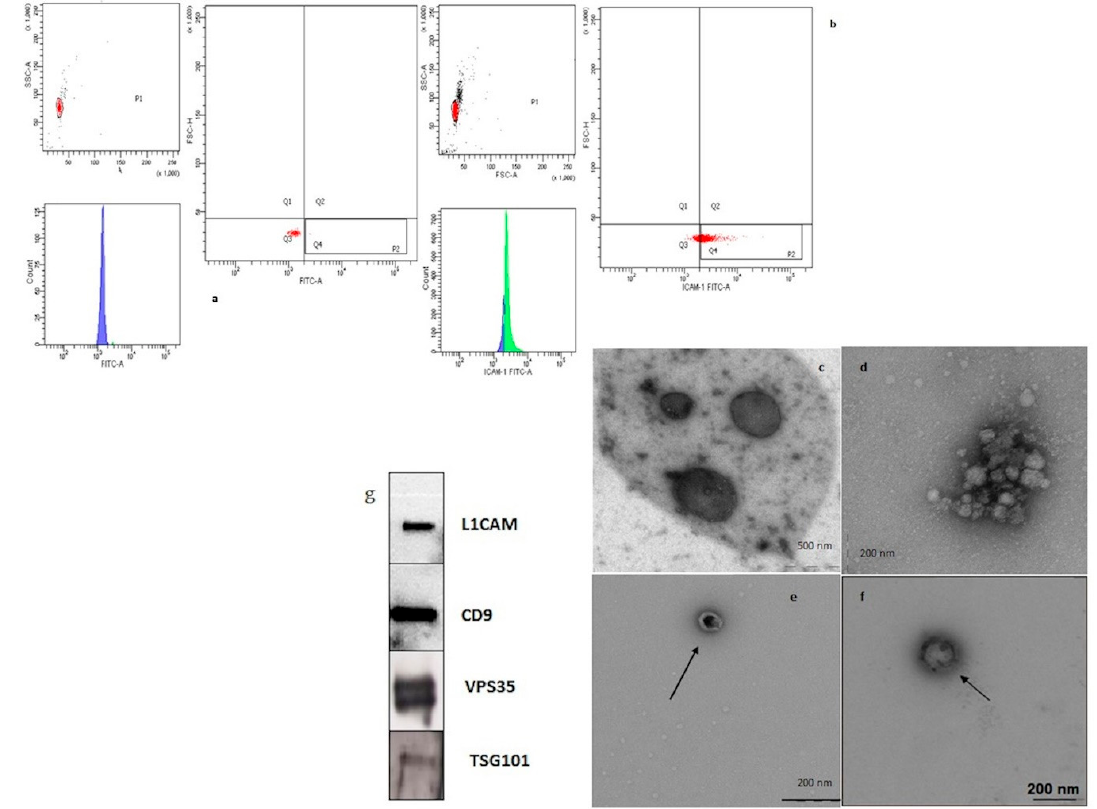
Figure 2. Total and neural-derived extracellular vesicles (NDEVs) enriched fractions from plasma. A and B. Flow cytometry analysis dot-plot. Panel ( a ) represents the negative control, ( b ) the neural-derived EVs from plasma of one AD patient. The EVs are stained with the fluorophore FITC. In Panel ( a ) there is an absence of fluorescent emission FITC (green peak), which instead is present in the positive sample panel ( b ). The same result is shown in the dot plot. Indeed, in the negative control the bead-Ab system is located in the quadrant Q3, in the absence of FITC fluorescence, while in the sample the signal shifts in the Q4 quadrant, where the FITC fluorescence is positive. C, D, E, F TEM analysis . Ultrastructural examination of fractions enriched in EVs ( c ) CD81-positive, ( d ) of neural derivation (L1CAM positive). TEM images showed that EVs were oval or oval or bowl-shaped capsuled. No substantial difference in the morphology of EVs isolated from fresh samples ( e ) compared with frozen ones ( f ). Western blot analysis. L1CAM, CD9, VPS35, TSG101 markers were all detected in the NDEVs enriched fraction of plasma samples ( g ).